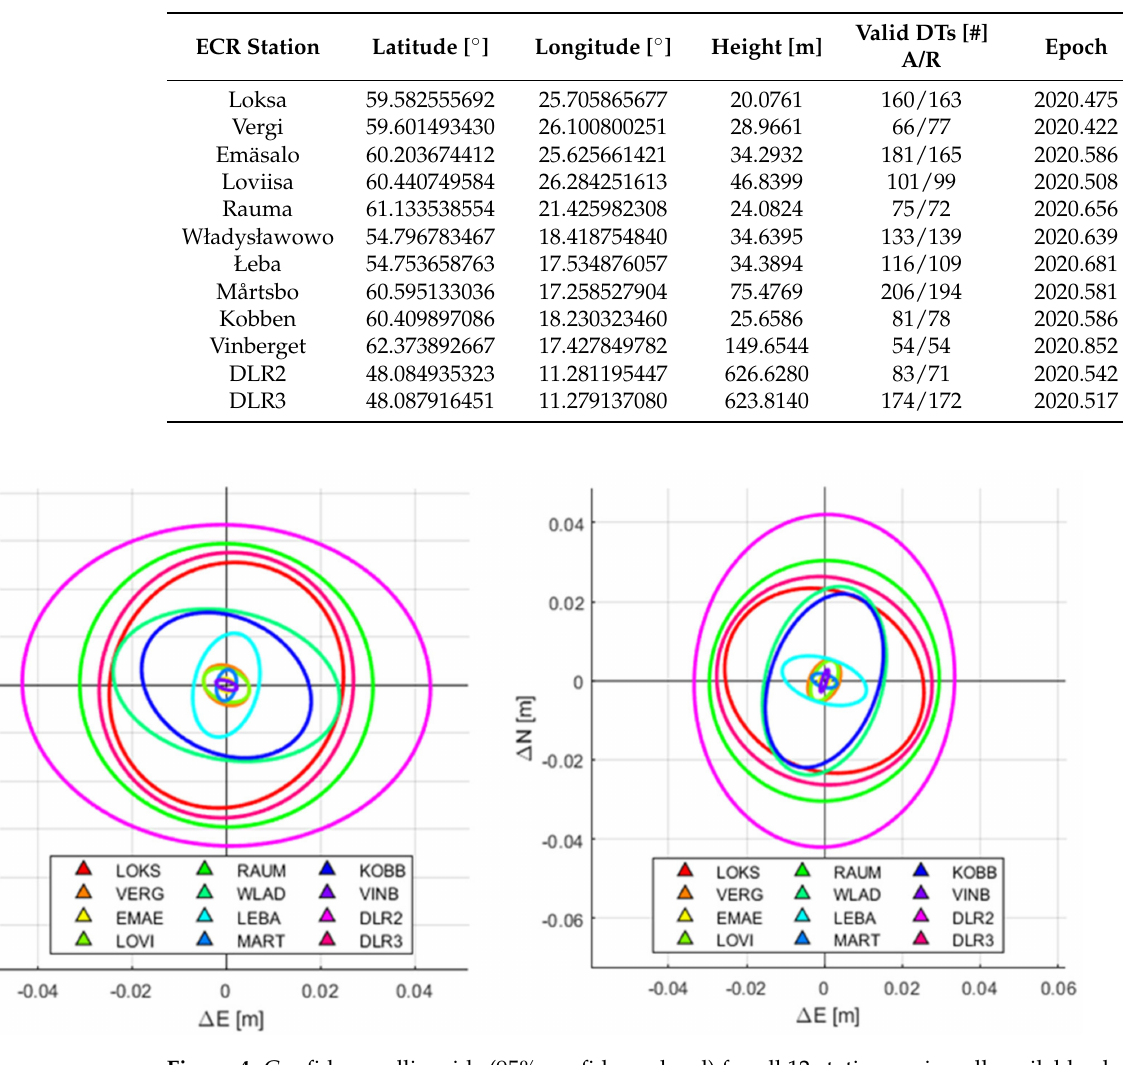
Figure 4. Confidence ellipsoids (95% confidence level) for all 12 stations using all available obser- vations in the year 2020. The confidence is shown in the local and east/height ( left image ) and north/east ( right image ), coordinate frame with respect to the estimated